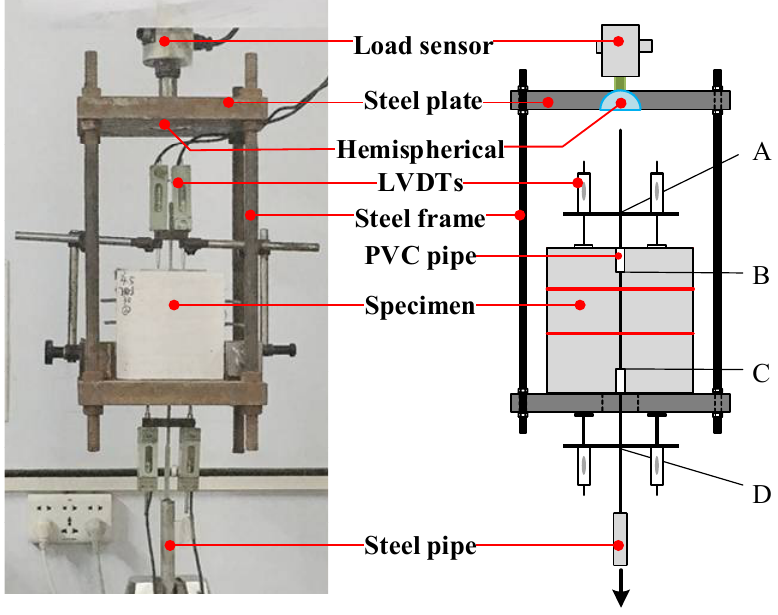
Figure 3. Schematic diagram of loading device. Table 1. Summary of results from steel strand–ECC unidirectional pullout tests. Group